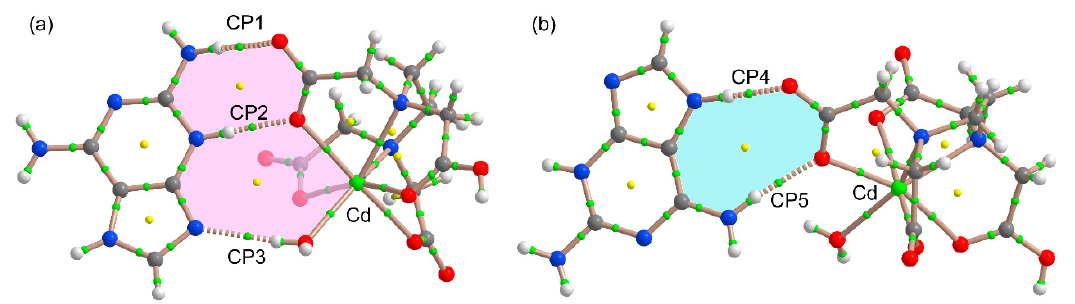
Figure 8. ( a,b ). Distribution of bond and ring critical points (green and yellow spheres, respectively) and bond paths in two dimers of complex 1 . The QTAIM data at the bond CPs denoted as CP1 to CP5 are given in Table 3. Table 5. Values of ρ r , V r and G r (in a.u.) for CP1 to CP5 as indicated in Figure 7. The dissociation energy (E dis ) of each H-bond based on V r and G r parameters are also indicated in kcal/mol.